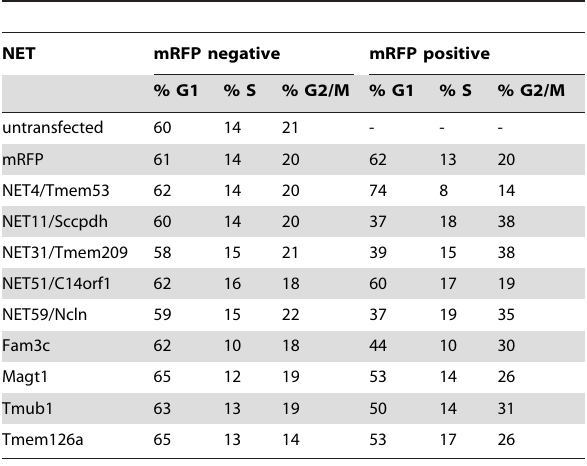
Table 1. Percentage of cells in each cell cycle phase by flow cytometry upon exogenous expression of NET-mRFP fusions.